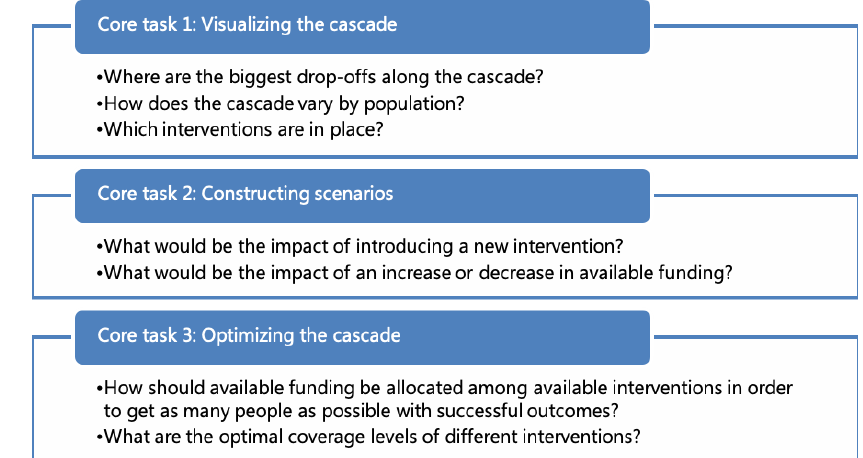
Figure 2. The types of questions designed to be answered by the Cascade Analysis